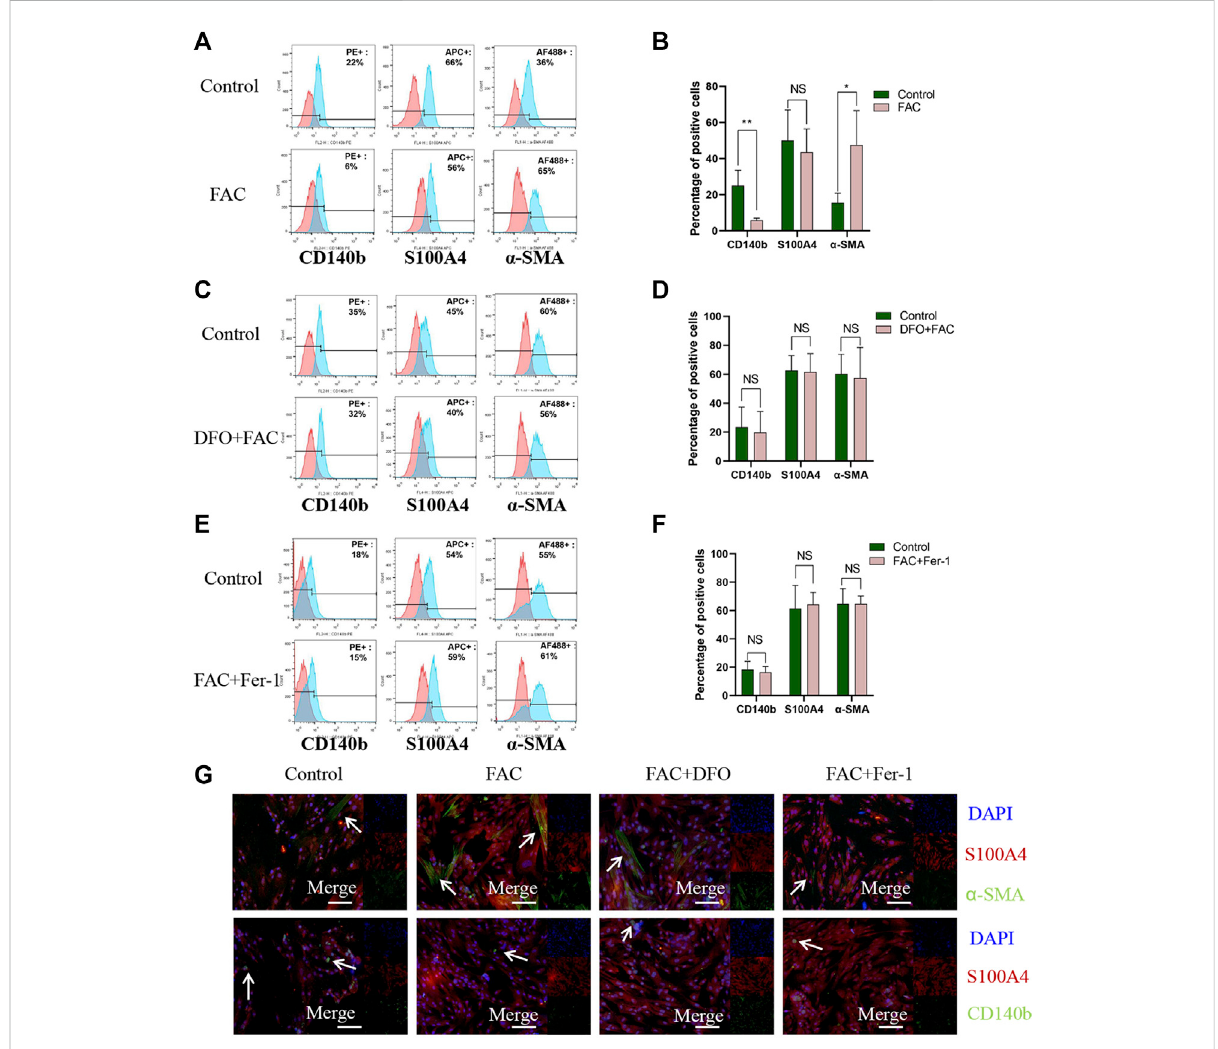
FIGURE 4 FAC induced ferroptosis of CD140b positive mesenchymal stromal cells and promoted a-SMA positive myo fi broblasts activation. (A – B) FACS analysesvisualizationofCD140b,S100A4anda-SMApositivecellpercentageinHEcESCswithFACtreatment (A) andstatisticalresults (B) indifferent treated groups. (C – D) FACS analyses visualization of CD140b, S100A4 and a-SMA positive cell percentage in HEcESCs with FAC and DFO treatment groups (C) and statistical results (D) in different treated groups. (E – F) FACS analyses visualization of CD140b, S100A4 and a-SMA positive cell percentage in HEcESCs with FAC and Fer-1 treatment groups (E) and statistical results (F) in different treated groups. FAC can signi fi cantly decrease CD140b positive mesenchymal stromal cells percentage and increase a-SMA positive myo fi broblasts proportion. (G) HEcESCs with different treatment groups were stained with antibodies against stromal cell markers. CD140b for mesenchymal stromal cells (green), S100A4 for fi broblasts (red), and a-SMA for myo fi broblasts (green) to further identify the effect of FAC. Scar bar: 50 μ m. Summary data are presented as the mean ± SEM. Signi fi cance in (B,D,F) was calculated using a Student t-test; * p < 0.05, ** p < 0.01, *** p <